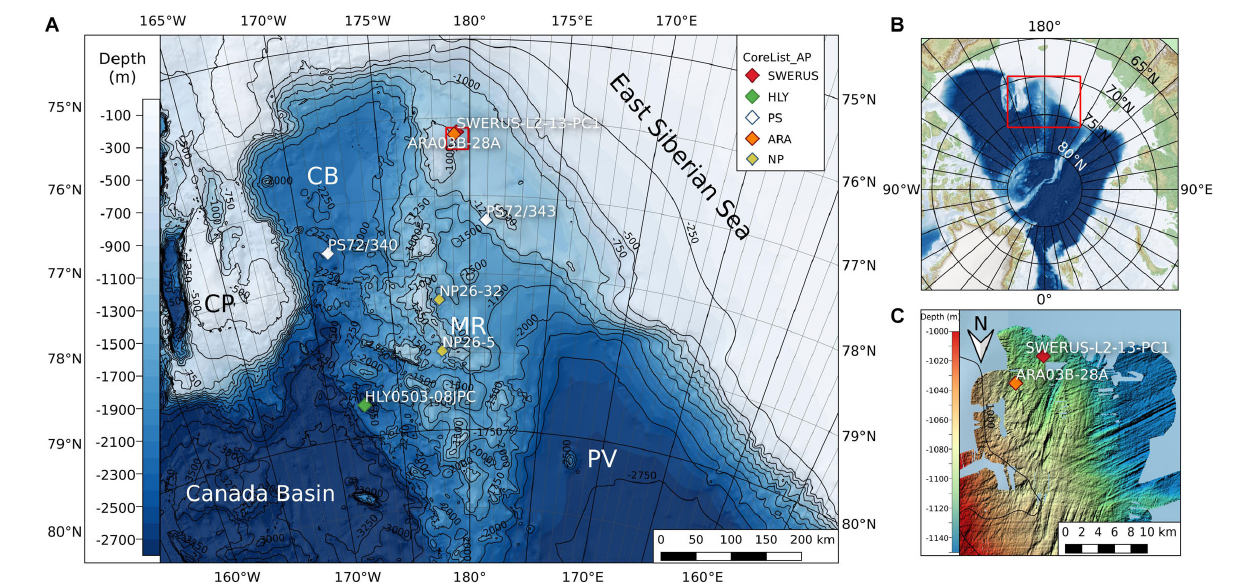
FIGURE 1 | Overview maps of Arlis Plateau and the Chukchi Sea, showing topography and bathymetry (data from IBCAO; Jakobsson et al., 2012). (A) Overview map displaying cores used in this study and reference cores mentioned in the text. (B) Overview map of the Arctic Ocean. (C) Detailed bathymetry around the core location of SWERUS-L2-13PC1. CB, Chukchi Basin; MR, Mendelev Ridge; CP, Chukchi Plateau; PV, Podvodnikov